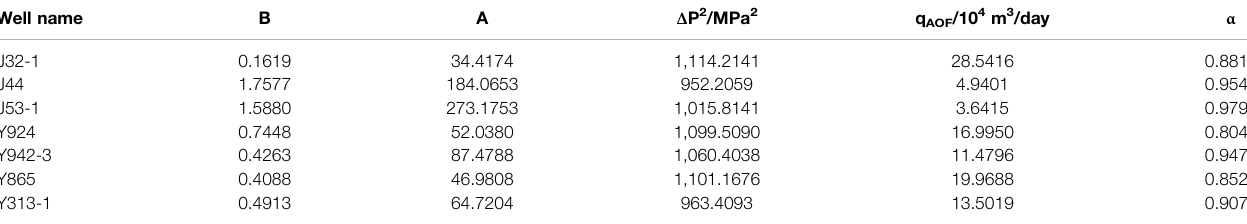
TABLE 3 | Calculation result of productivity characteristic parameter of single-well and single-point deliverability formula.